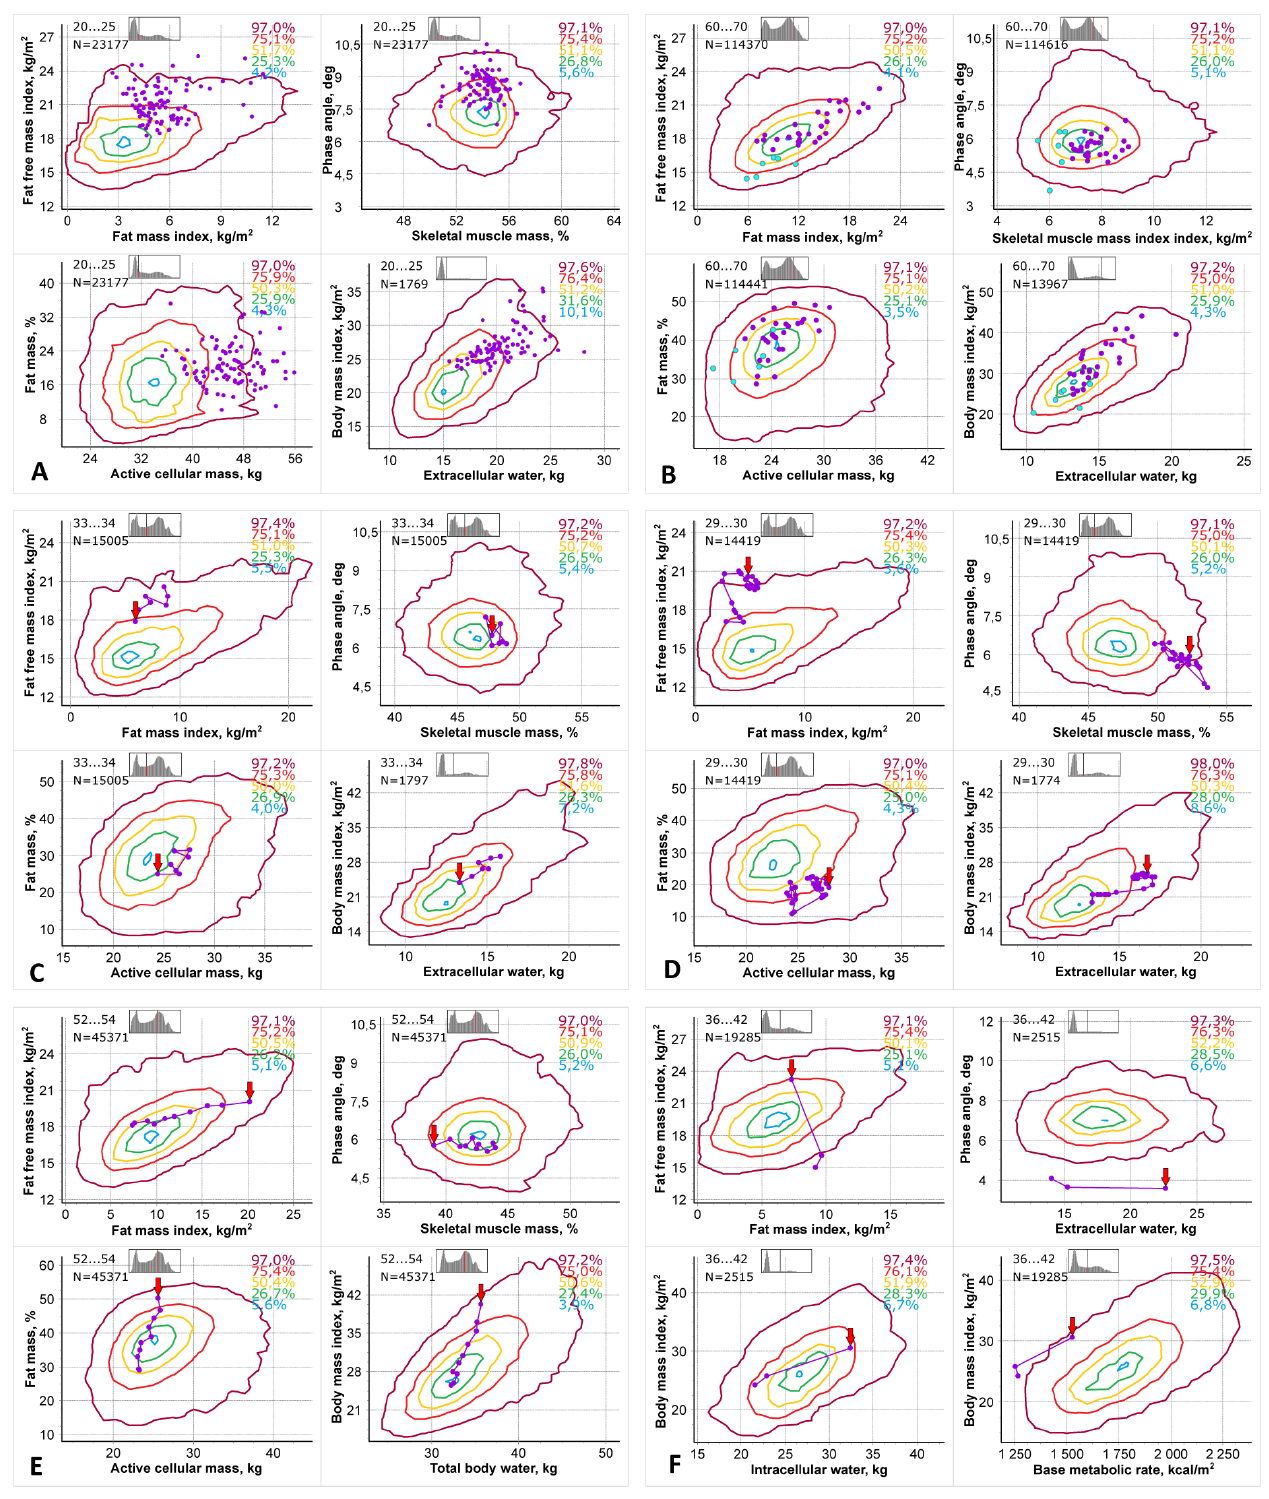
Fig.5. Examples of “ 2DBIA ” visualization of bioimpedance examination by 8 parameters, with centile lines, arranged in two -dimensional graphs. Every point corresponds individual examination data. Dynamic observation of one patient is presented by line connected points. The arrow marks to the first examination